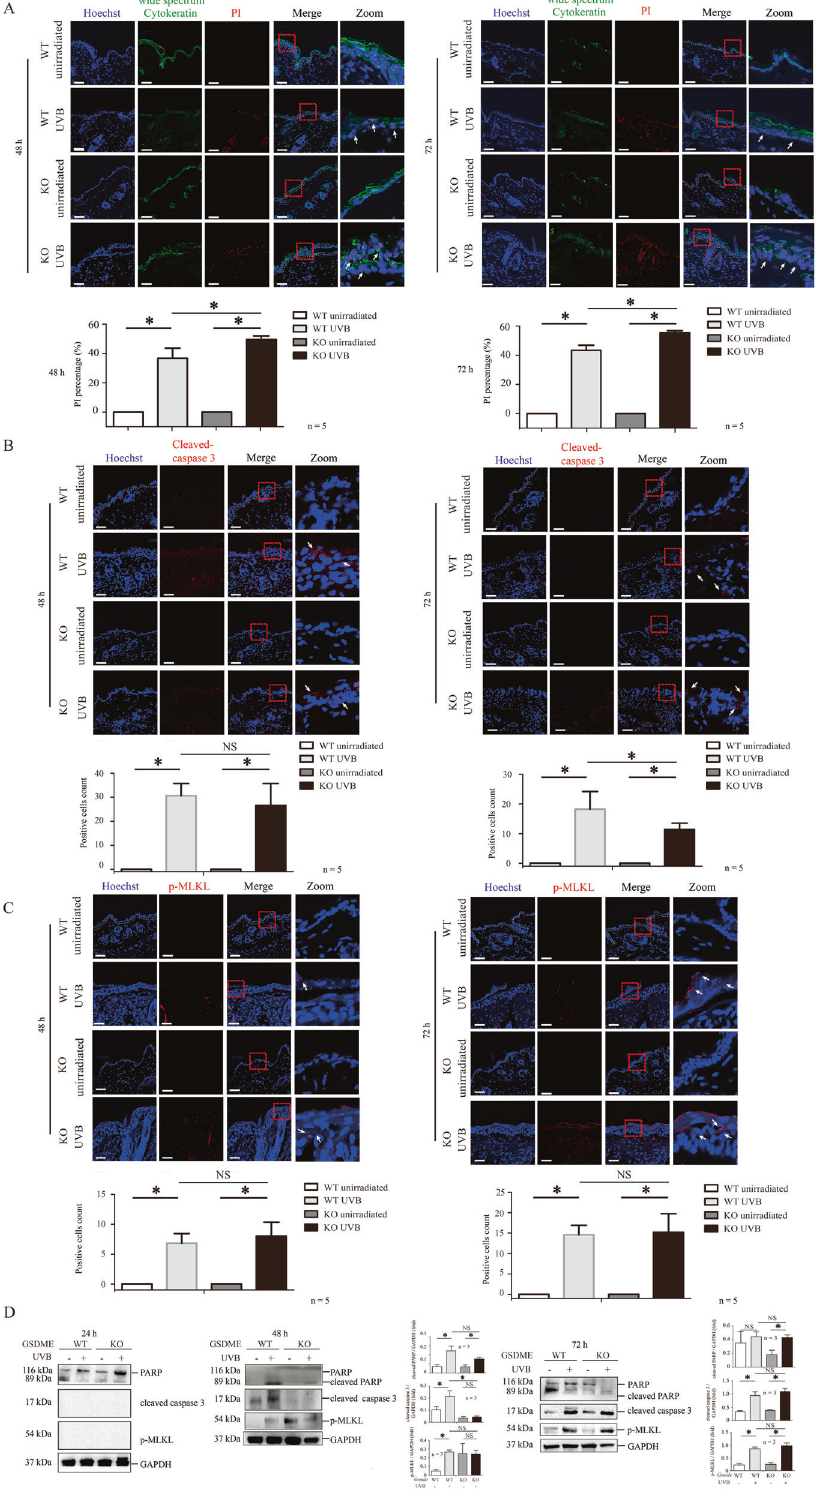
Fig. 2 Pyroptosis, apoptosis, and necroptosis were triggered simultaneously in UVB-challenged mice. A The level of keratinocyte death was determined by PI staining. Wide spectrum Cytokeratin was used to indicate keratinocytes. Scale bar represents 100 μ m, n = 5. B , C Caspase 3 ( B ), and phosphorylation at Ser345 site of MLKL ( C ) were detected by immuno fl uorescence assay. The nucleus was stained by Hoechst ( n = 5). Scale bar represents 100 μ m. D PARP, caspase 3, and phosphorylation at Ser345 site of MLKL were detected by western blotting assay in WT or Gsdme − / − mice at 24, 48, and 72 h after UVB exposure. Quanti fi cation of the interested protein bands was shown ( n = 3). * P < 0.05. NS nonsense.